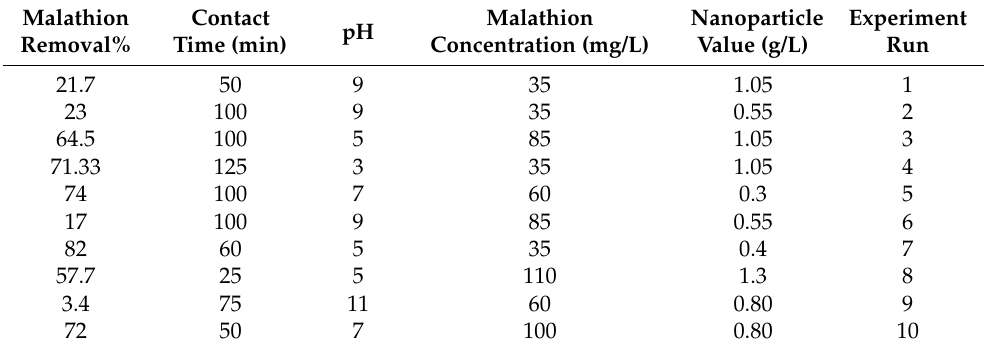
Table 3. Experimental results were designed using the central composite design (CCD) ap- proach